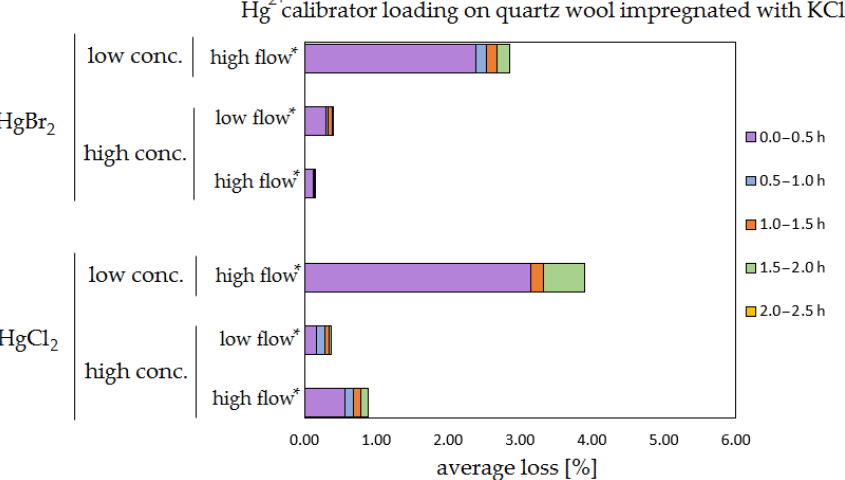
Figure 9. Results of the stability test for the calibrator loading of 197 Hg 2 + (radiotracer) on quartz wool impregnated with KCl. Low concen- trations were loaded with less than 1ng Hg per time period, and high concentrations were loaded with more than 50ng of Hg per time period. Low airflow experiments were performed with 100mLmin − 1 airflow, while high airflow experiments were performed with 400mLmin − 1 flow. Asterisks mark the results that only have the first four time